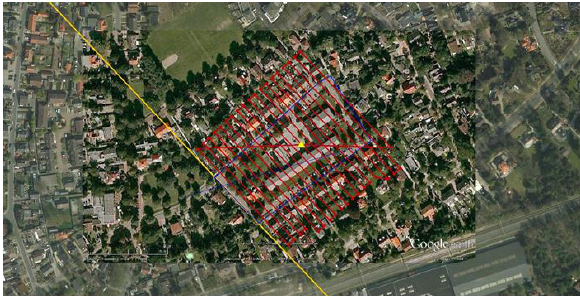
Figure 8: Flightplan second flight Nunspeet by Orbit GIS